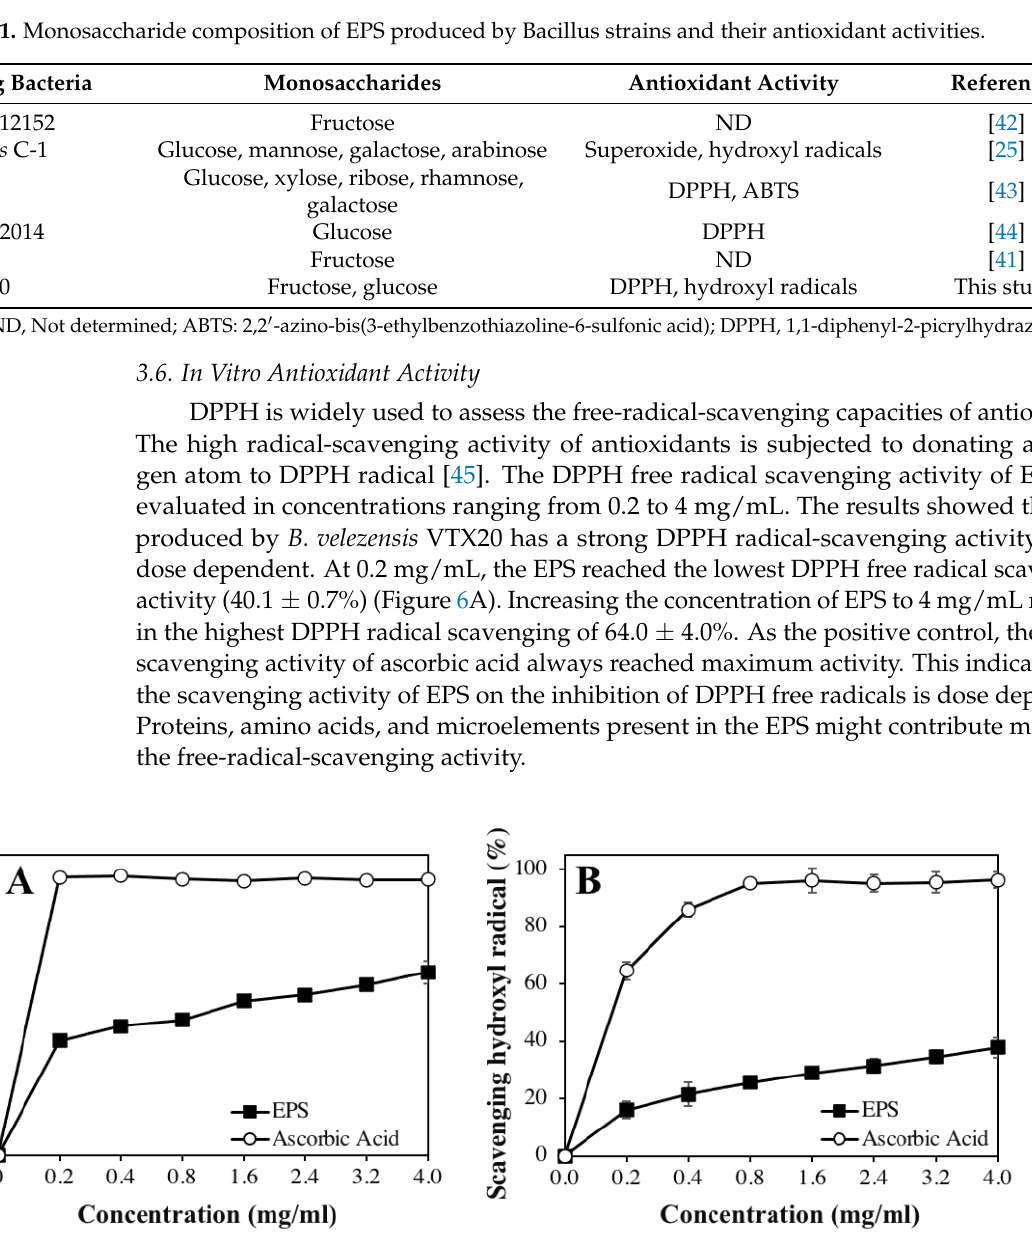
Table 1. Monosaccharide composition of EPS produced by Bacillus strains and their antioxidant activities.